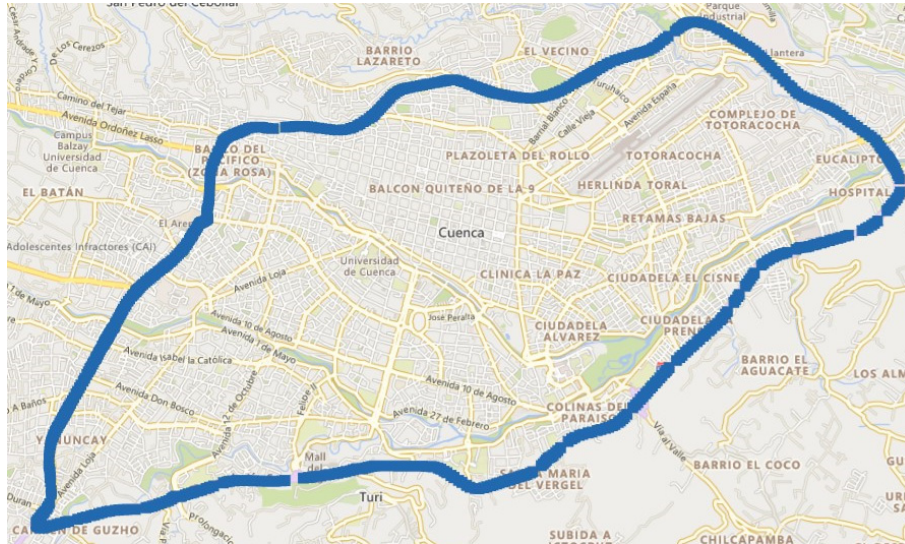
Figure 7. Trajectory used to test the EV.